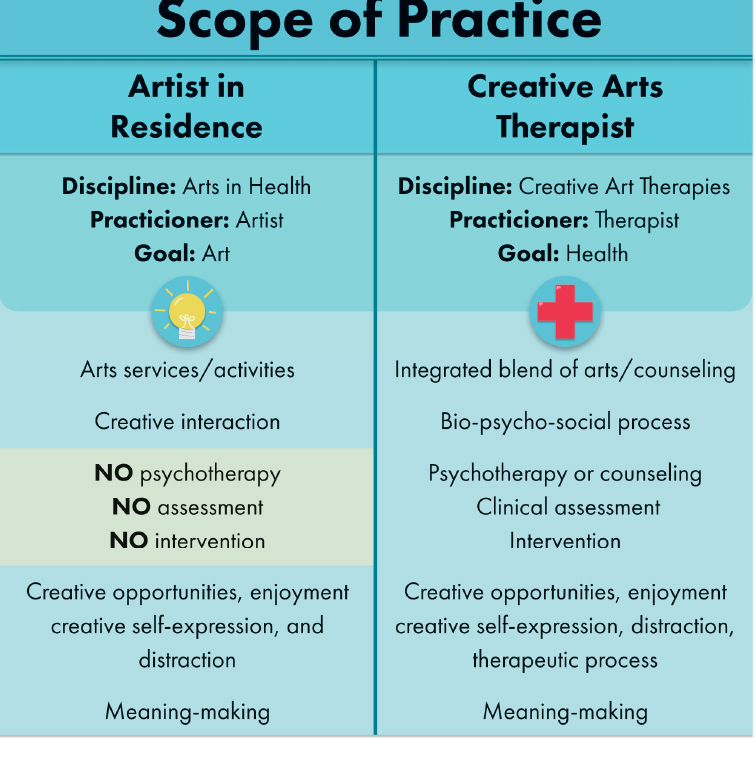
Figure 1. Scope of Practice.